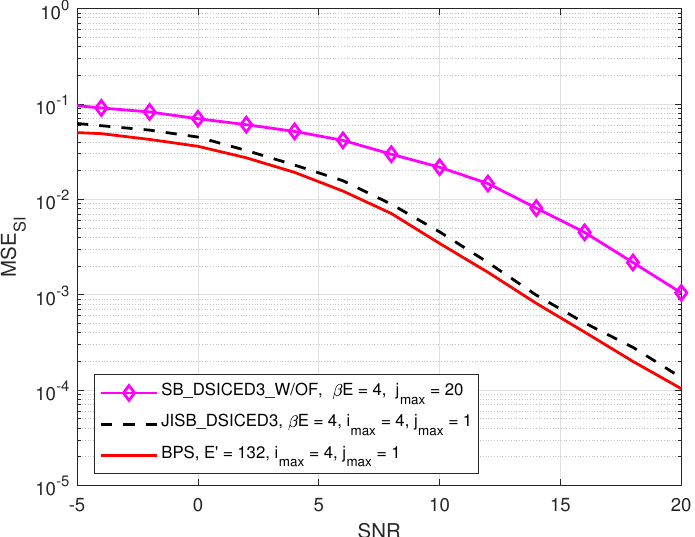
Figure 5. MSE SI versus SNR, p B / σ 2 w ; R = 1/2, i max = 4, j max = 20, p SI / σ 2 w = 30 dB, β E = 4 symbols, and E = 128 symbols.